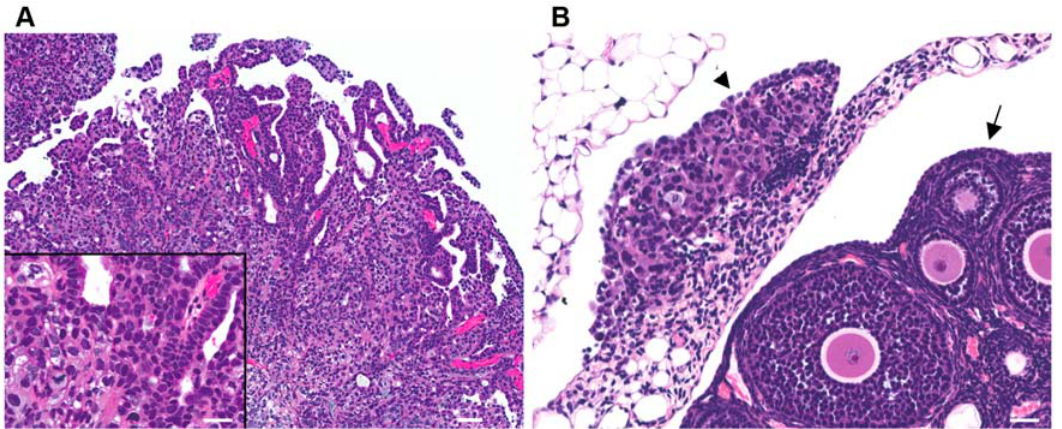
Figure 2. Human OVCA cell xenograft in mouse peritoneal cavity. (A) Representative OVCA exhibits predominantly solid tumor growth, with evidence of papillary projections and occasional minute cysts (bar=25 m m). Inset, higher resolution photomicrograph depicting cuboidal to polygonal pleomorphic microcystic epithelium with anisokaryosis and atypical mitoses of ovarian cancer cell nuclei (bar=50 m m). (B) OVCA tumor nodule implant on uterine infundibulo-ovarian ligament (arrowhead) adjacent to the ovary (arrow) (bar=25 m m). Tumor implants occurred throughout the peritoneal cavity, peri-ovarian connective tissues, and invaded surrounding tissues such as intestines, liver and diaphragm. Hematoxylin and eosin (H&E) stained, paraffin-embedded tissue sections.